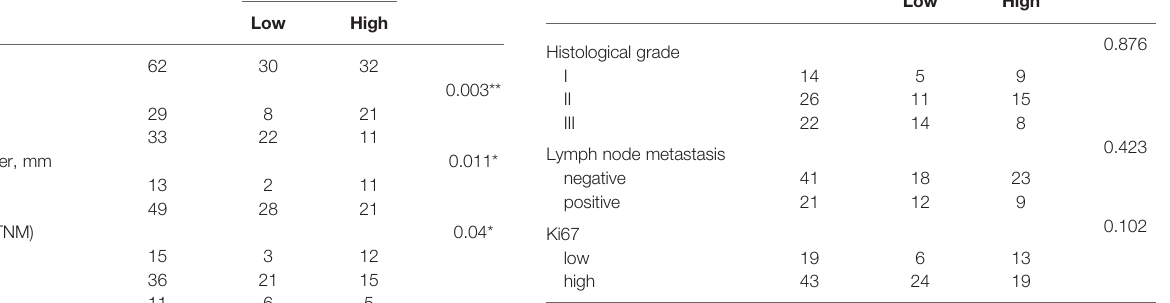
TABLE 1 | Associations between ADAMS9-AS2 expression and clinicopathological parameters. Clinicopathological parameters